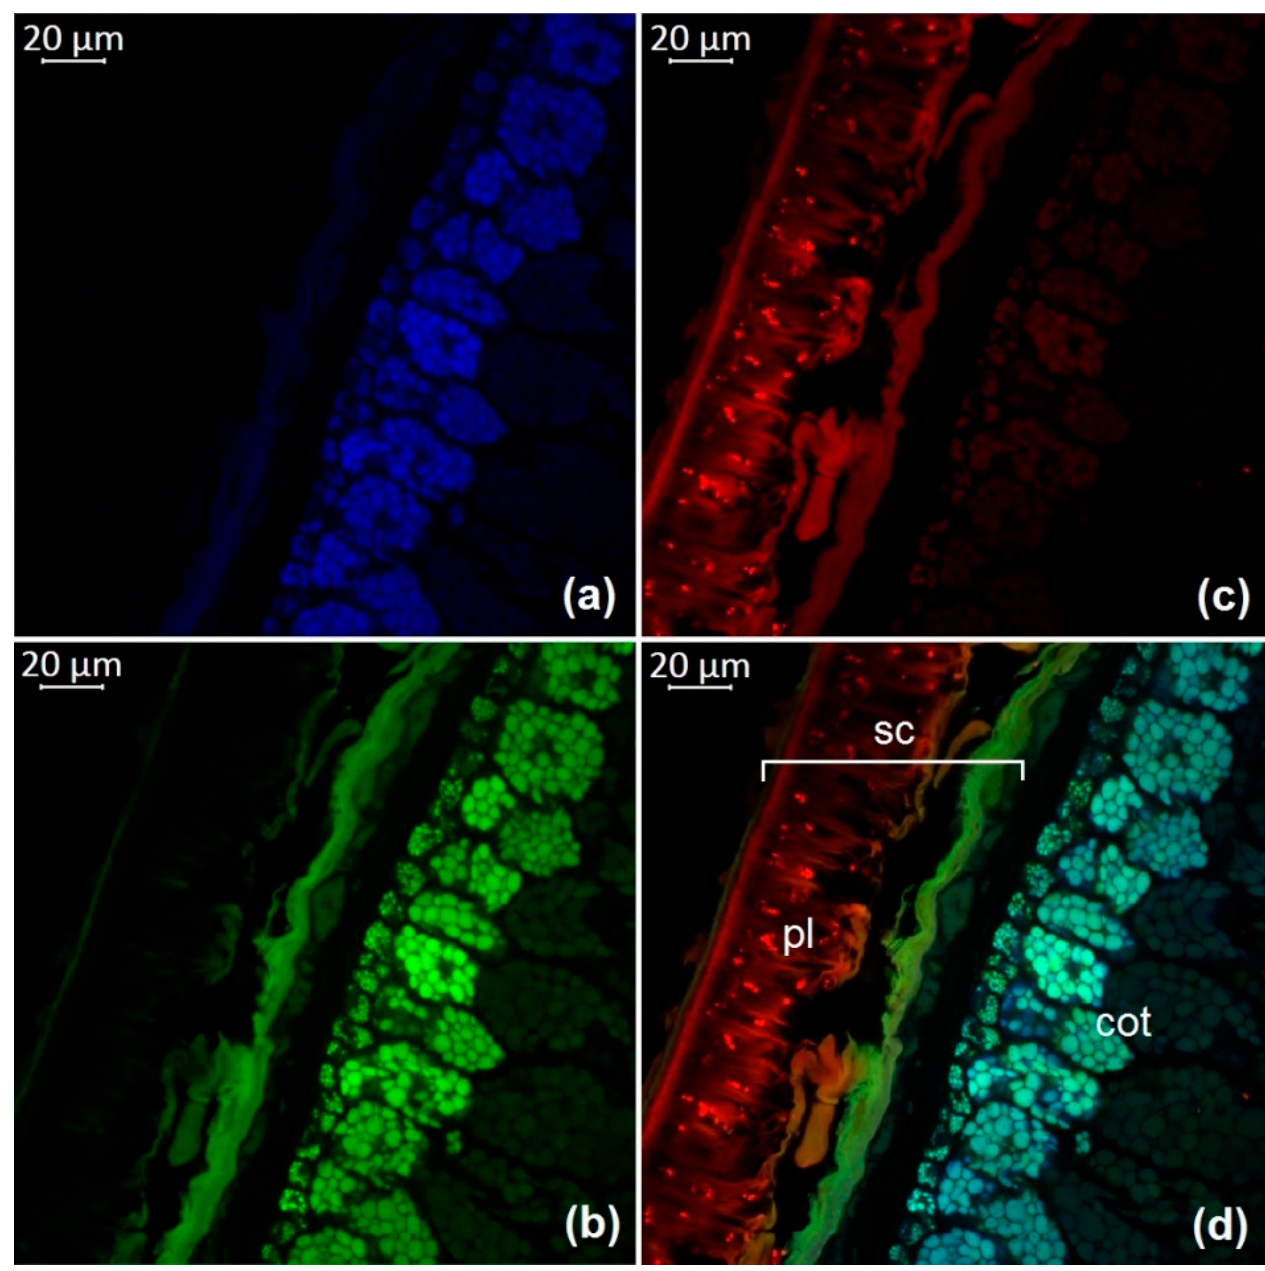
Figure 6. A transverse section of a soybean seed (variety k-5373): ( a ) excitation at 405 nm with emission in the range of 400–475 nm (blue); ( b ) excitation at 488 nm with emission in the range of 500–545 nm (green); ( c ) excitation at 488 nm with emission in the range of 620–700 nm (red); ( d ) merged; cot, cotyledon; pl, palisade layer; sc, seed coat.